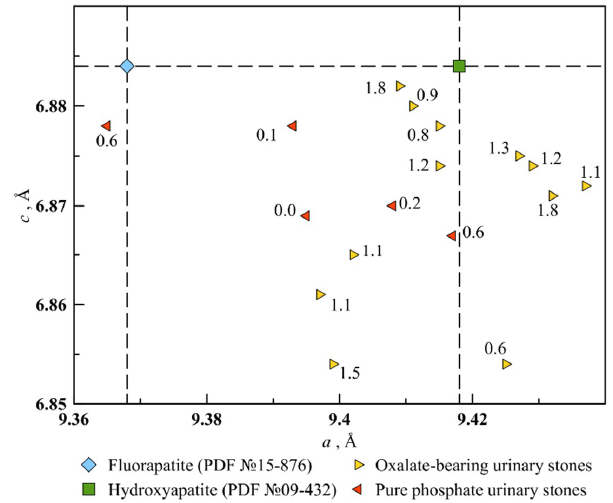
Figure 7. Unit cell parameters of the apatites formed in humans.